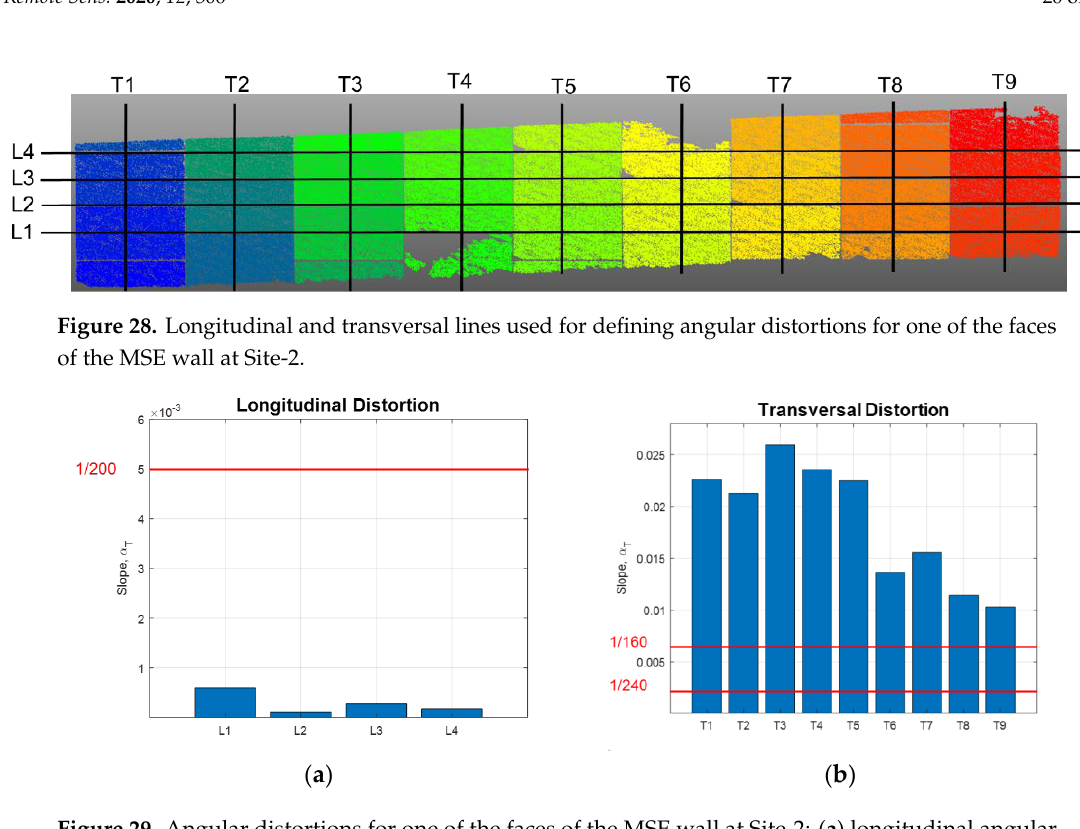
Figure 29. Angular distortions for one of the faces of the MSE wall at Site-2: ( a ) longitudinal angular distortion along lines L1-L4, and ( b ) transversal angular distortion along lines T1-T9 (the horizontal red lines represent the tolerable angular distortions). Table 11. MLS-based panel parametrization for one of the MSE wall faces at Site-2.